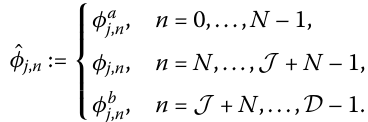
partially outside the interval. But a basis that is defined on the interval is required. The construction of such a basis as proposed in [20] is used in this work. Let I = [ a , b ] be an interval. For each boundary N boundary scaling functions and boundary wavelets are constructed, such that the number of vanishing moments is preserved. Inside the interval, the ordinary functions are